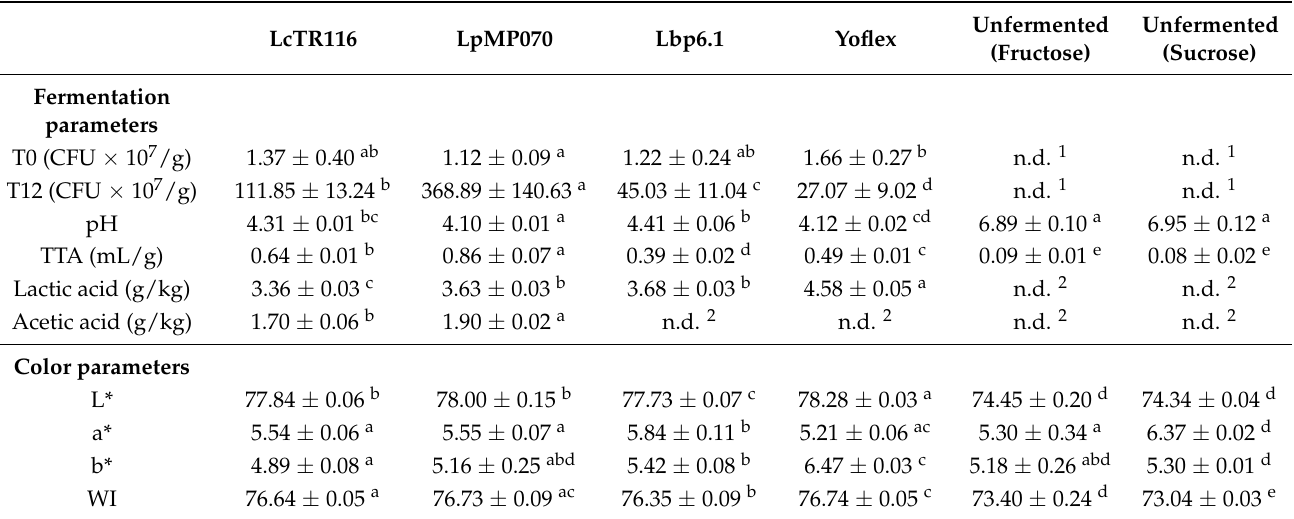
Mean values ± standard deviations. Values in the same row followed by the same superscript letters are not significantly different ( p > 0.05). n.d. 1 : no bacterial growth on MRS and GM17 agar; n.d. 2 : not detected or below 0.3